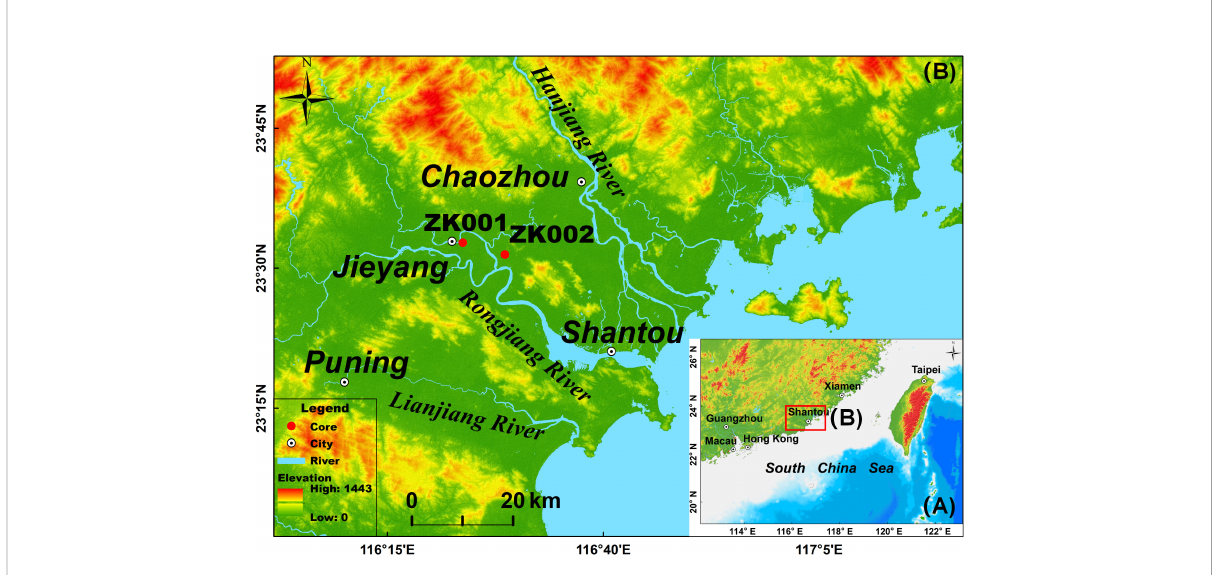
FIGURE 1 Location of the Chaoshan plain and sites of cores ZK001 and ZK002. (A) General map around the Chaoshan plain; red square box encompasses the major area of the Chaoshan plain. (B) The major area of the Chaoshan plain consists of the Hanjiang Delta, the Rongjiang alluvial plain, and the Lianjiang alluvial plain; two boreholes including cores ZK001 and ZK002 were obtained from the Rongjiang alluvial plain. Base maps are from http://www.gscloud.cn/ and